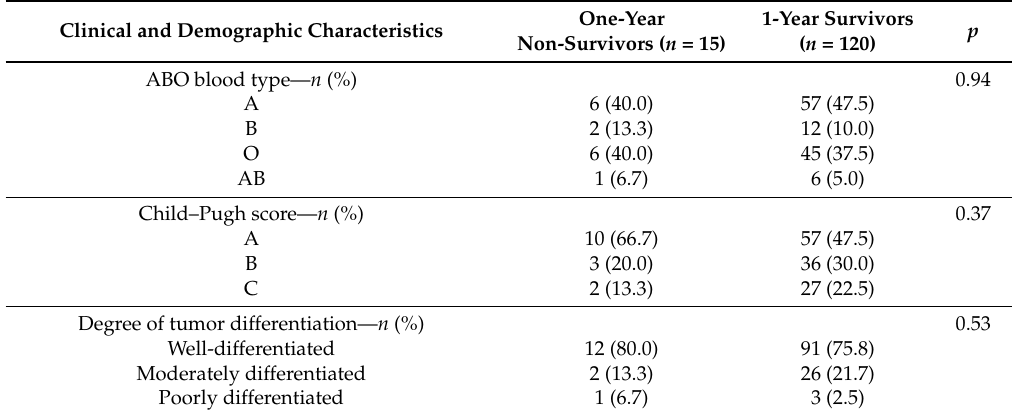
Table 1. Clinical and demographic characteristics of surviving and non-surviving patients at one year of liver transplantation (LT) for hepatocellular